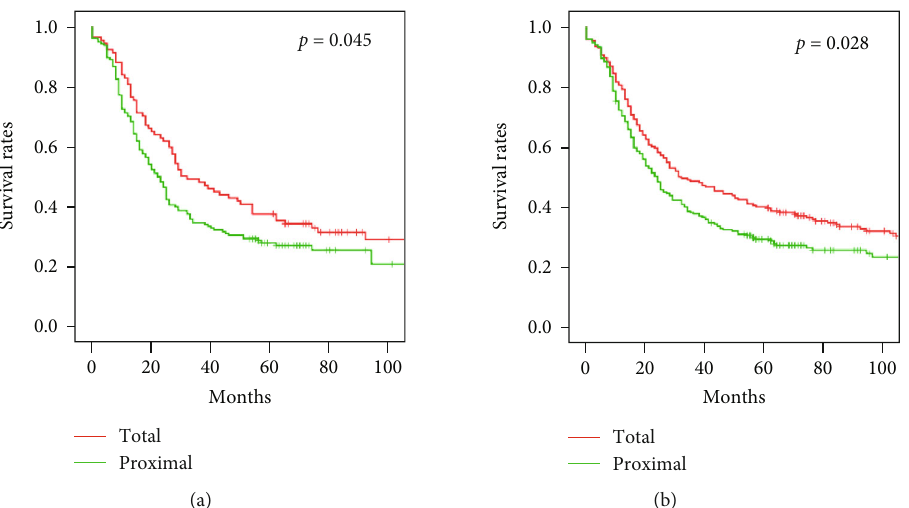
Figure 6: Survival of patients with upper gastric cancer and treated by total or proximal gastrectomy. (a) Invasion of the serosa, p = 0 : 045 ; (b) Borrmann type 3 or 4 in fi ltration, p = 0 : 028 . Table 7: One-, 3-, and 5-year survival of upper gastric cancer patients with total or proximal gastrectomy. Total